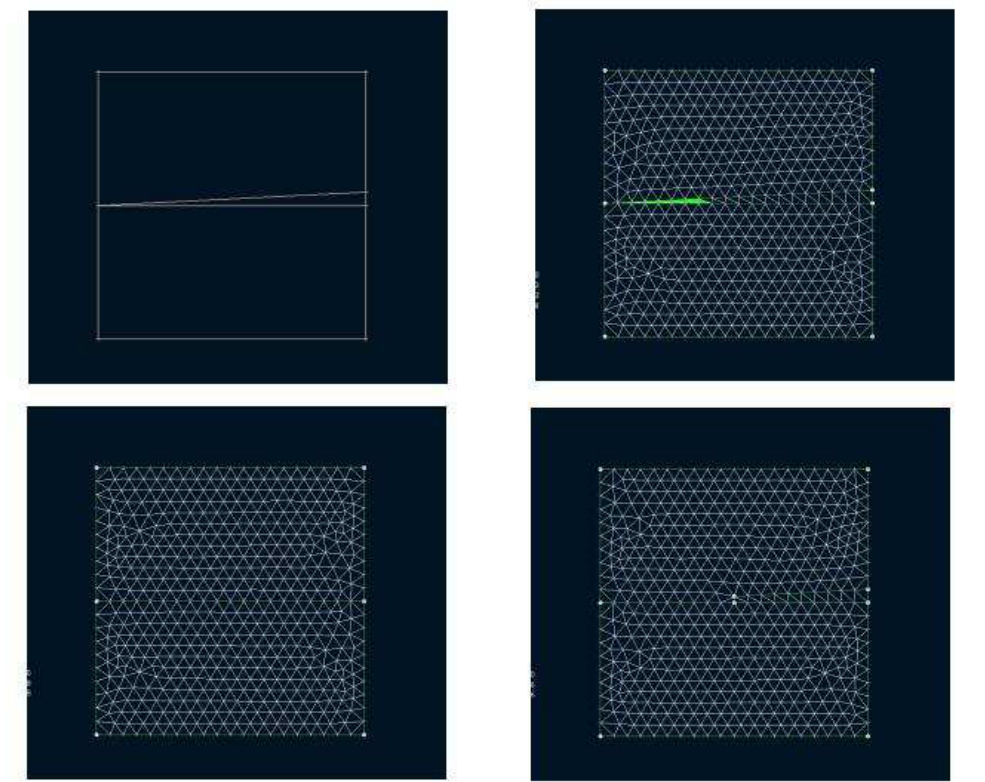
Figure 3: Sharp angle causing highly skewed